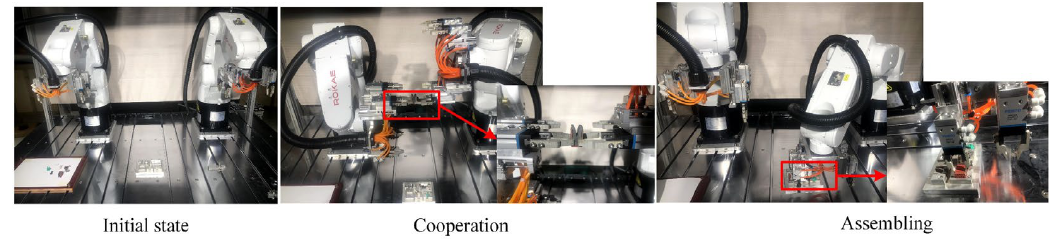
Figure 25. Two-arm cooperation robot physical prototype.